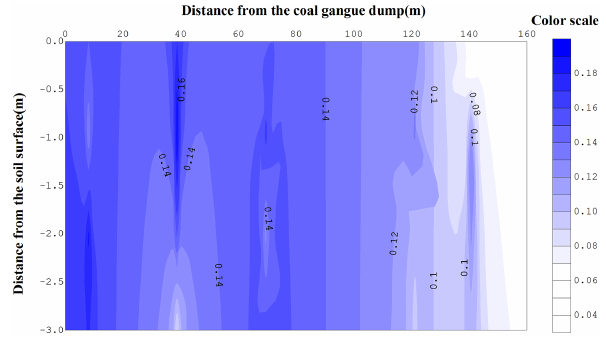
Figure 3. The concentration distribution map of heavy metal Cd at the L2